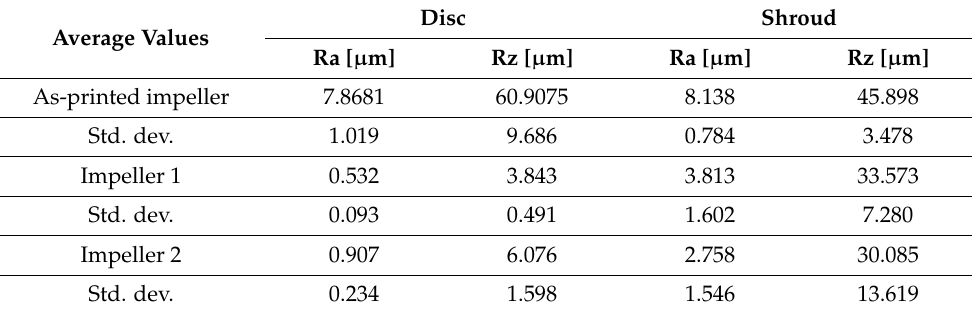
Table 6. Roughness